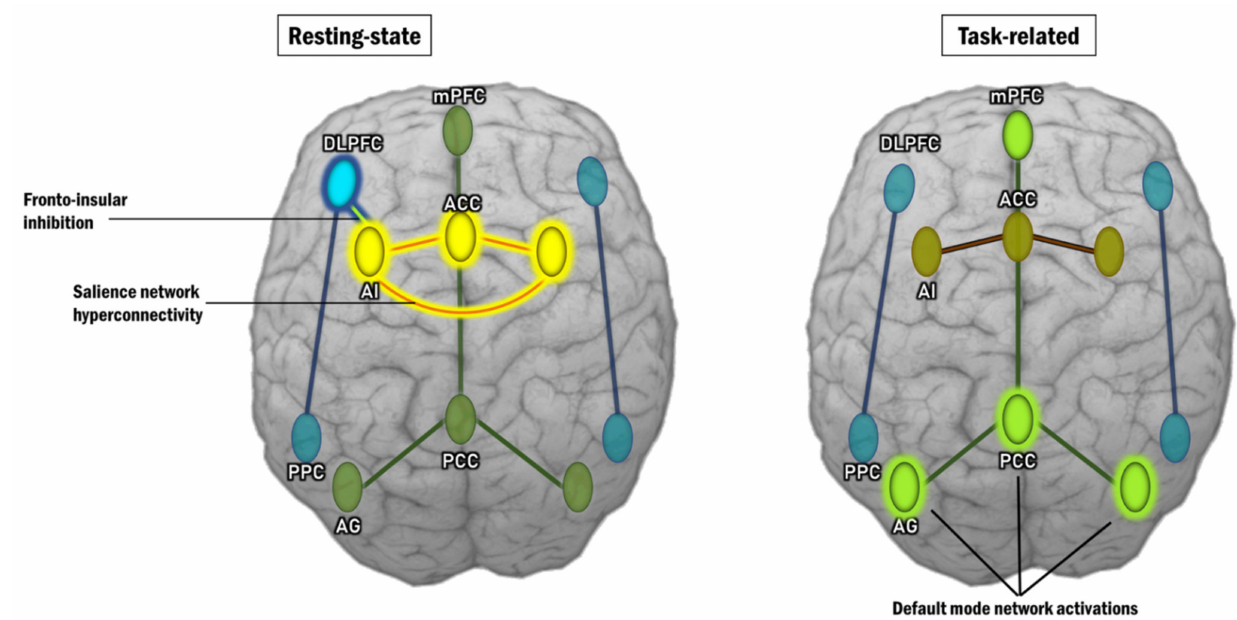
Figure 5. Resting-state aberrant connectivity and task-related abnormal activations that are observed in schizophrenic patients. AG—Angular gyrus; mPFC—Medial prefrontal cortex; PCC—Posterior cingulate cortex; AI—Anterior insula; ACC—Anterior cingulate cortex; DLPFC—Dorsolateral prefrontal cortex; PPC—Posterior parietal